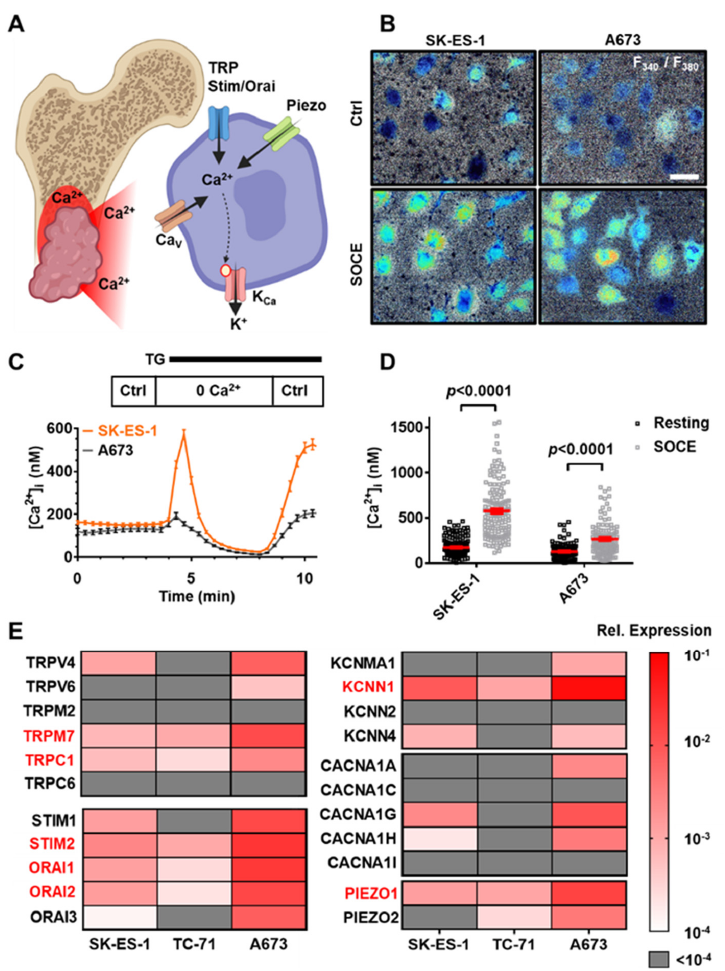
Figure 1. Ewing sarcoma cells express multiple Ca 2+ (regulated) ion channels. ( A ) Representation of osteolysis-induced Ca 2+ release from the bone tissue in EwS. Cells can respond to this phenomenon by utilizing Ca 2+ -permeable and Ca 2+ -regulated ion channels prominently from the TRP, Stim, Orai, Piezo, Ca V (encoded by CACNA genes), as well as K Ca channels (encoded by KCNN genes). ( B ) Representative F 340 /F 380 ratio images derived from intracellular Ca 2+ measurements under control conditions (Ctrl) and during store-operated Ca 2+ entry (SOCE). Brighter and warmer colors indicate higher [Ca 2+ ] i . Scale bar= 20 µ m. ( C ) Summarized Ca 2+ measurement results of SK-ES-1 (orange) and A673 (black) EwS cells, where individual data points depict the mean [Ca 2+ ] i of respective cells at a given time. Resting [Ca 2+ ] I was derived from the initial (Ctrl) superfusion; store release was elicited by thapsigargin treatment in the absence of [Ca 2+ ] e ; SOCE can be observed when applying thapsigargin with Ca 2+ -containing Ctrl solution. ( D ) [Ca 2+ ] i at resting condition (black) and upon triggering SOCE (peak concentration; grey). Data points depict the [Ca 2+ ] i of individual cells. N SK-ES-1 = 4, n SK-ES-1 = 108; N A673 = 4, n A673 = 111. ( E ) Heatmap shows ion channel gene expression in EwS cell lines compared to housekeeper genes GAPDH and YWHAZ . Color code is represented on the right. N = 3, n = 6. Data in ( C , D ) are represented as mean ± SEM. ( A ) was created with BioRender.com, accessed on 21 April